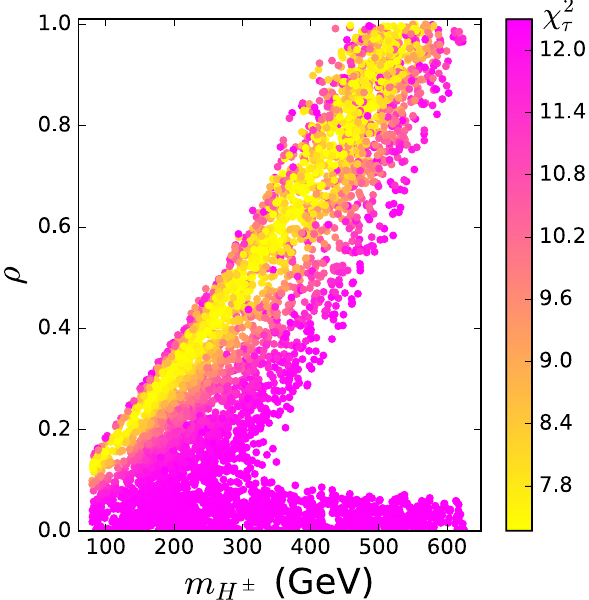
Fig. 1 The surviving samples satisfying the constraints of ”pre-muon g − 2” and χ 2 τ < 12.3 projected on the plane of ρ versus m H ±